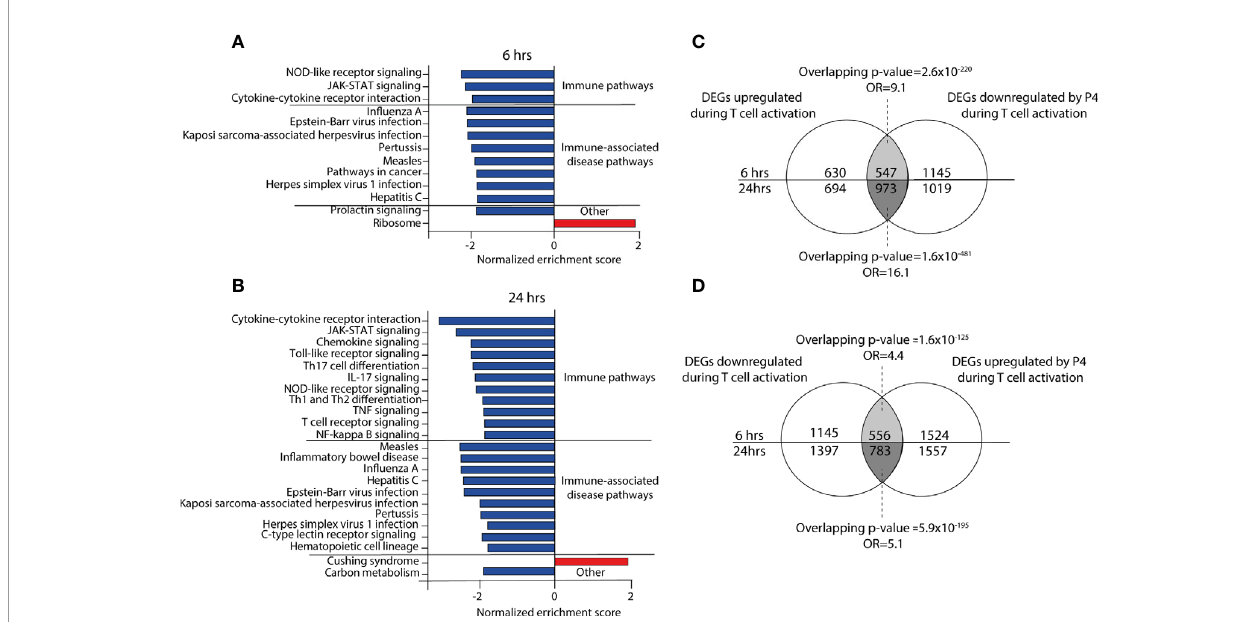
FIGURE 2 | Progesterone down regulates immune-related pathways during activation of CD4 + T cells. (A, B) Bar graphs showing the normalized enrichments score on the x-axis from the KEGG gene set enrichment analysis of the P4 response genes (DEGs comparing activation in the presence of P4 as compared to activation alone) at 6 and 24 hrs. All pathways have an FDR adjusted p-value <0.05. (C, D) Venn diagrams of the overlapping DEGs between up-and down-regulated genes in T cells activated in the presence or absence of 50 µM P4. n=3 unactivated, n=8 activated with and without 50 µM P4. DEGs, differentially expressed genes: OR, odds ratio; P4,